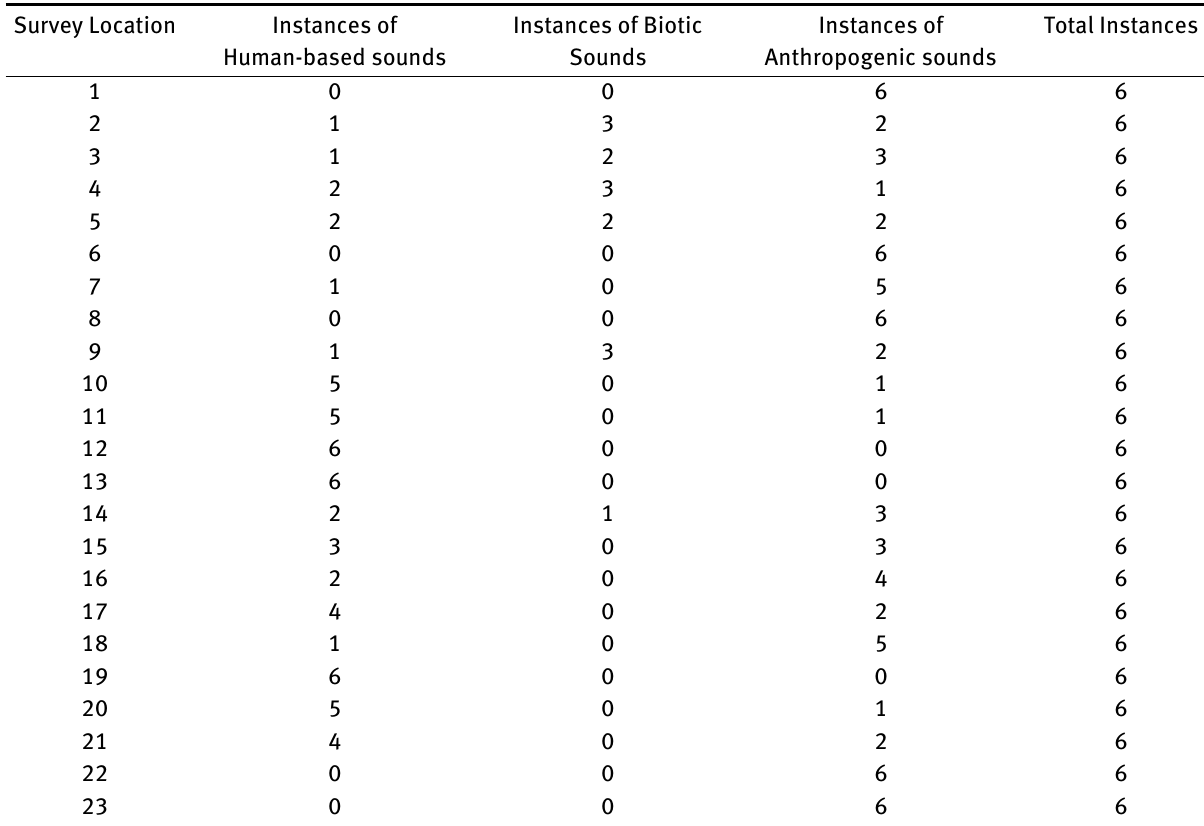
Table 5: Table showing the existence of different sound sources in each location. Survey Location Instances of Human-based sounds